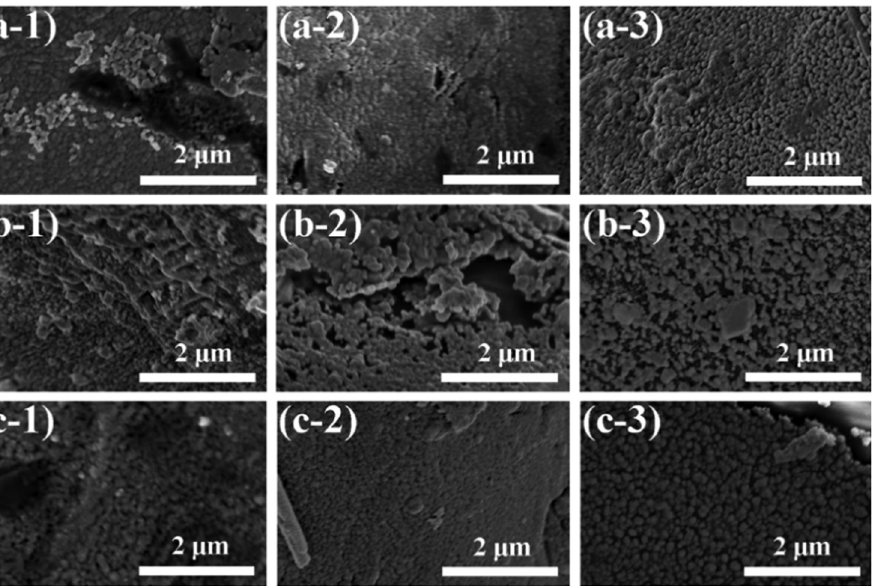
Figure 3: E ff ects of technological parameters by magnetron sputtering, viz., ( a ) sputtering time, ( b ) sputtering power, and ( c ) sputtering pressure on surface morphologies of PP fi bers.